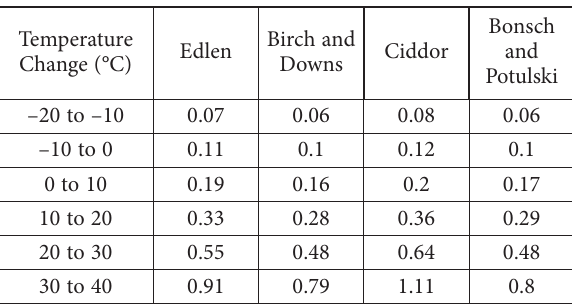
Table 2. Differences in EDM corrections w.r.t